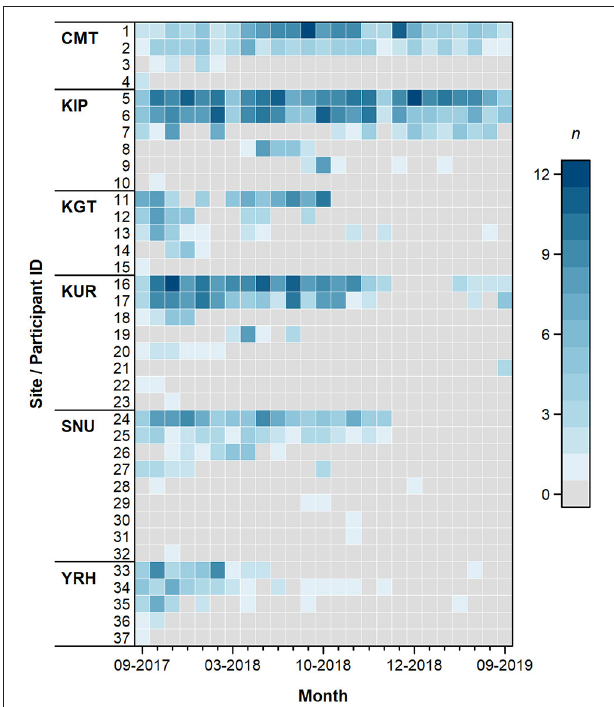
FIGURE 6 | Temporal distribution of data collected by all participants at all the monitoring sites for the monitoring period from September 2017 to September 2019. Level of engagement is based on the number of measurements ( n ) contributed per